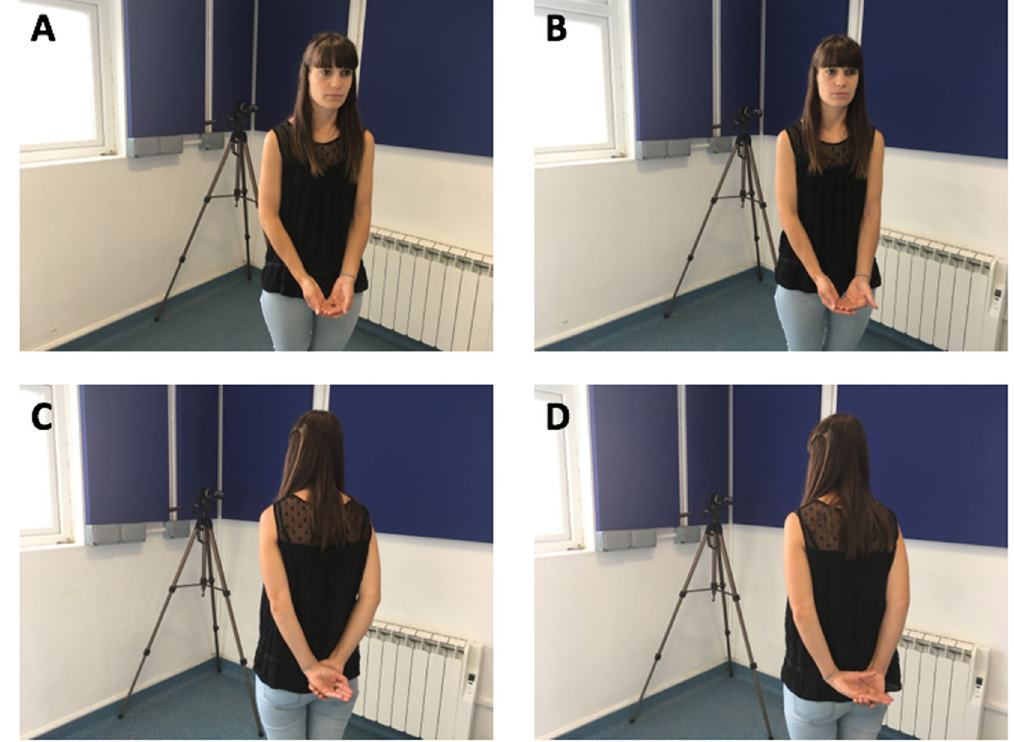
Figure 2. Experimenter’s position in the ( A ) Attentive Food ( B ) Attentive No food ( C ) Not attentive Food ( D ) Not attentive no Food